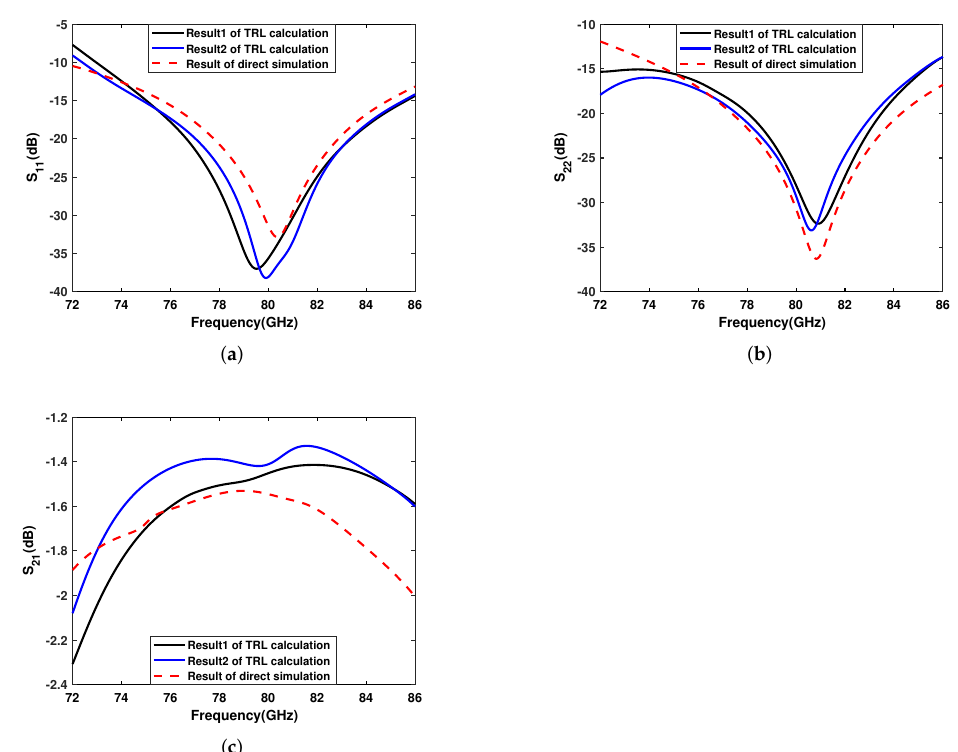
Figure 19. Comparison of the package-board transition results calculated by the TRL method and the direct simulation results. ( a ) S 11 , ( b ) S 22 , ( c ) S 21 /S 12